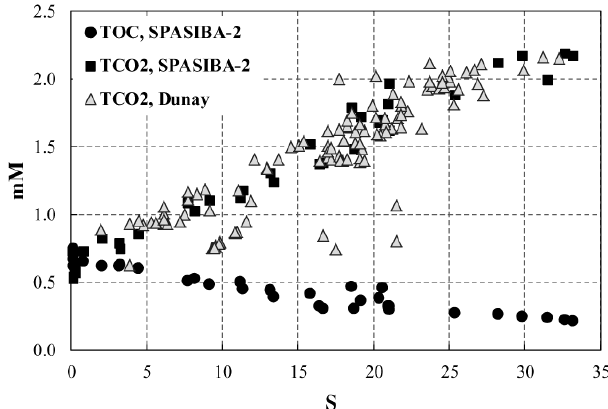
Fig. 7. The mean values of TOC and TCO 2 vs. S measured in September 1991 (adopted by Cauwet and Sidorov, 1996) and in September 1997 onboard H/V Dunay